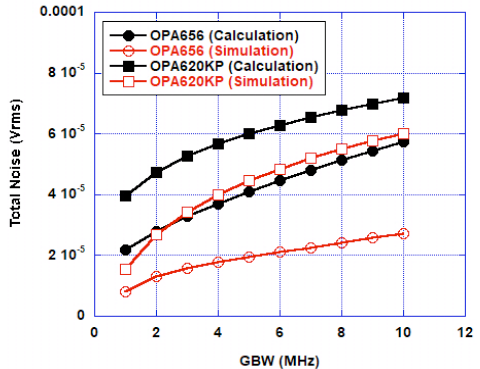
Fig. 4. Comparison results using mathematical calculation and simulation approach to investi- gate the GBW against NTot of the two